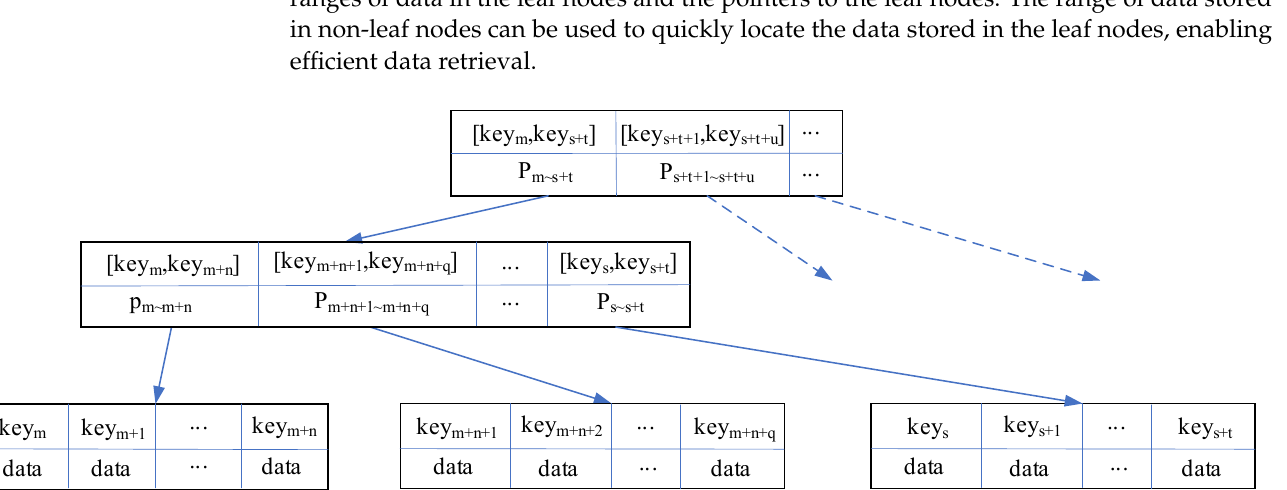
Figure 1. B+ tree structure.